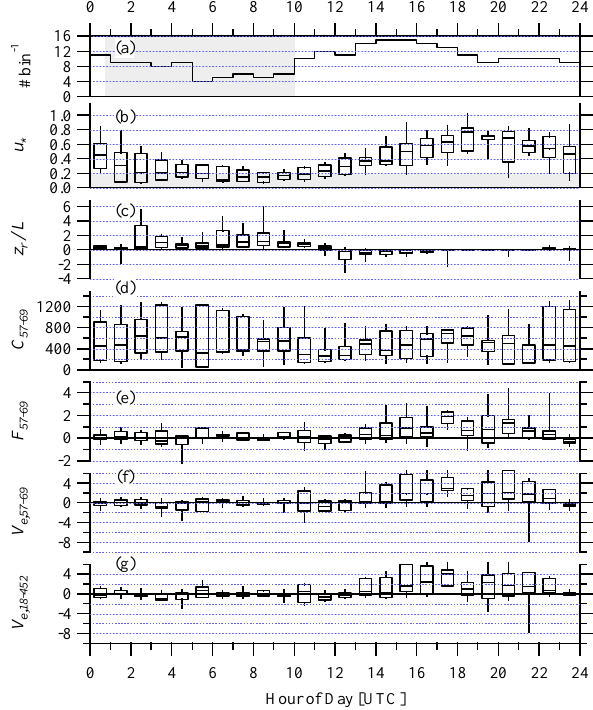
Figure 3. Number of 30-min measurements after filtering for wind direction and friction 2 Fig. 3. Number of 30-min measurements after filtering for wind velocity (a) , percentiles (10, 25, 50, 75, and 90%) of the diurnal variation in friction velocity, 3 direction and friction velocity (a) , percentiles (10, 25, 50, 75, u * [m s -1 ] (b) , stability, z r /L (c) , filtered concentration C 57-69 [10 6 m -3 ] (d) , flux, F 57-69 [10 6 m - 4 and 90%) of the diurnal variation in friction velocity, u ∗ [ms − 1 ] 2 s -1 ] (e) , exchange velocity, V e,57-69 [mm s -1 ] (f) of the 56.8-68.6 nm size range, and exchange 5 (b) , stability, z r /L (c) , filtered concentration C 57 − 69 [10 6 m − 3 ] velocity, V e,18-452 [mm s -1 ] (g) of the 18.4-452 nm size range. Shading indicates night-time (a) 6 (d) , flux, F 57 − 69 [10 6 m − 2 s − 1 ] (e) , exchange velocity, V e, 57 − 69 and u * < 0.2 m s -1 (b). 7 [mms − 1 ] (f) of the 56.8–68.6nm size range, and exchange veloc- ity, V e, 18 − 452 [mms − 1 ] (g) of the 18.4-452nm size range. Shading indicates night-time (a) and u ∗ < 0 . 2ms − 1 (b) .